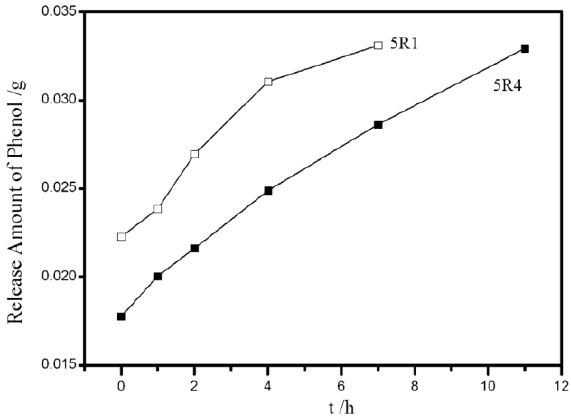
Figure 18. Release profiles of typical 5 R1 and 5 R4 with different lengths. Reproduced with permission from [107]. Copyright 2015, John Wiley and Sons. Table 5. The catalytic activities of the samples with different pore size for phenol hydroxylation. Table 4. Catalytic activity of Fe–NTRs with different length. Reproduced with permission from [107]. Copyright (2015) John Wiley and Sons.